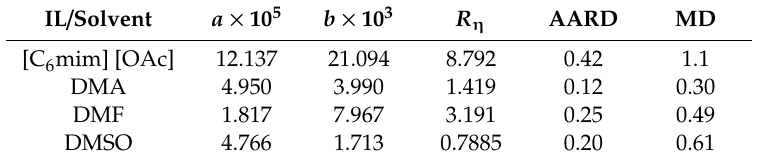
Table 14. The fit parameters a , b , and R η for the hard-sphere theory in Equations (11) and (12). IL / Solvent a × 10 5 b × 10 3 R η AARD